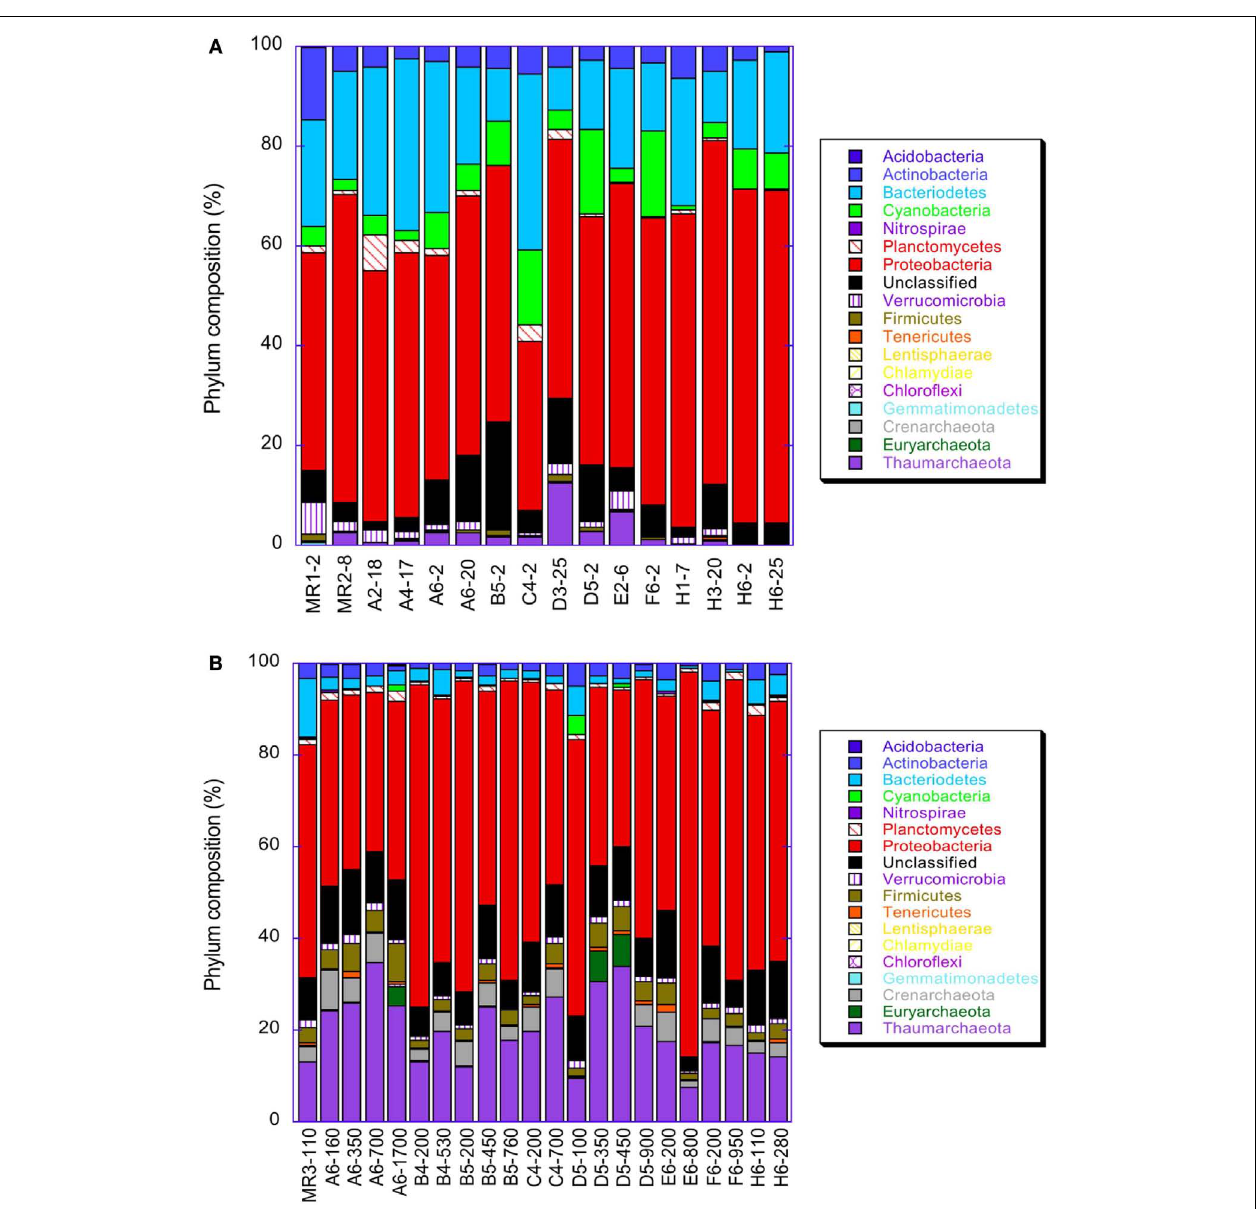
FIGUREA2 | Distribution of various taxa in pyrosequenced libraries of rrs in samples from the northern Gulf of Mexico: (A) samples taken from depths ≤ 25m; (B) samples from depths ≥ 100m.